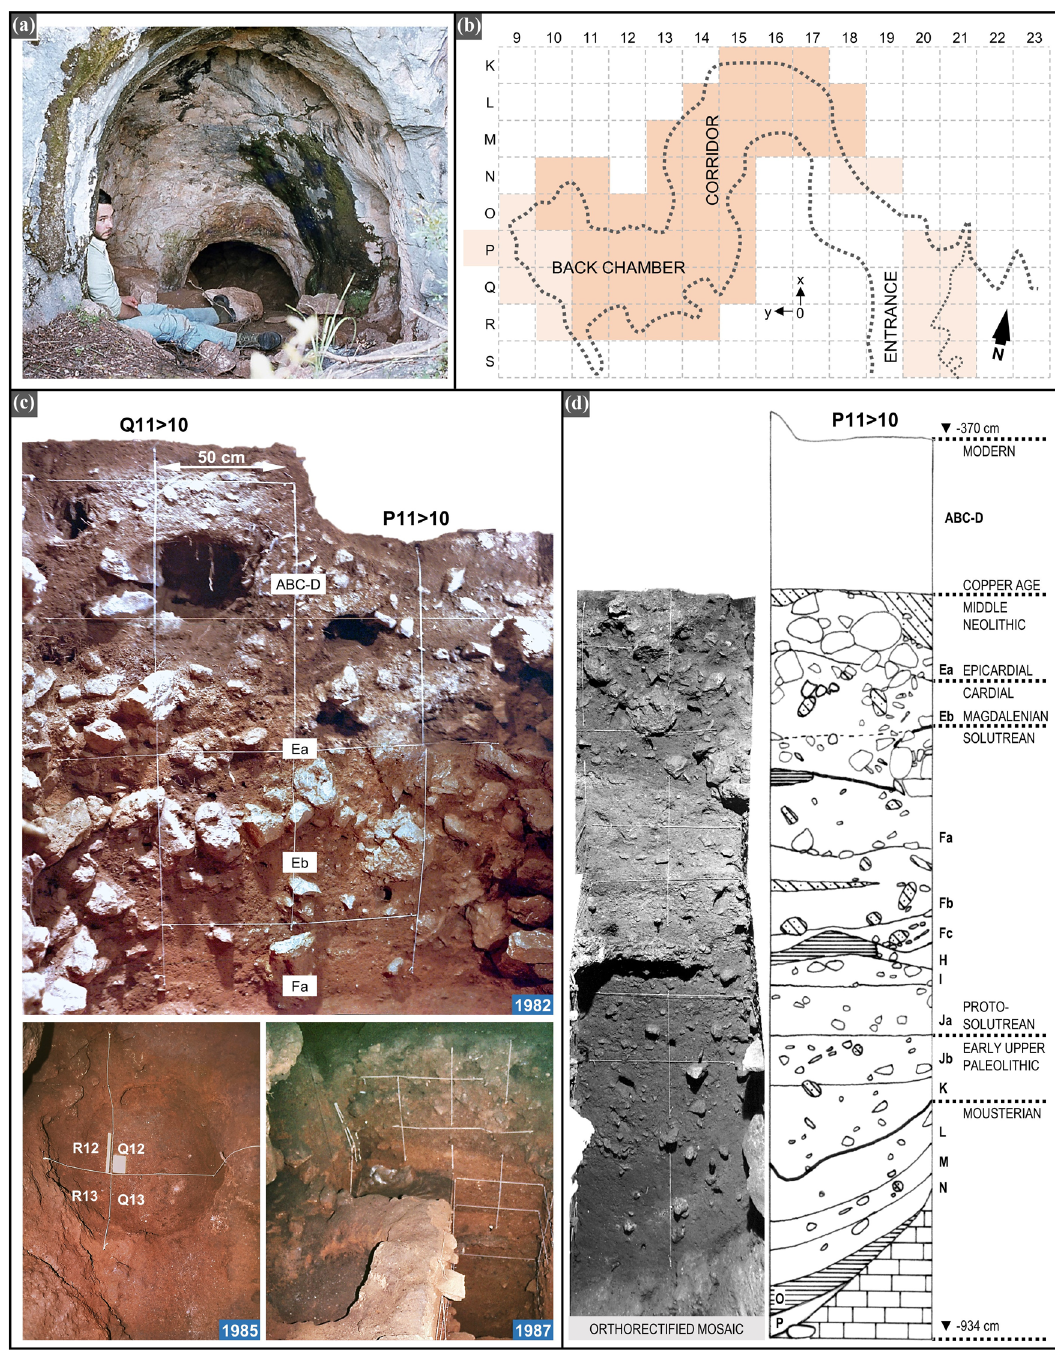
Figure 3: Gruta do Caldeirão. Excavation and stratigraphy. ( a ) The entrance to the cave in 1980, at the beginning of the second fi eld season. ( b ) Outline of cave walls at the surface of the sedimentary deposit and excavation grid ( in darker shade, those in which the Neolithic was excavated ) . ( c ) Stratigraphy and post - depositional disturbance in the upper part of the sedimentary fi ll ( top ) ; note the large subsurface hollows in layer ABC - D ( badger burrows ) and a comparable feature in squares Q - R/12 - 13, which was fi lled with a mix of Neolithic and Magdalenian material and penetrated deeply into the underlying Solutrean sequence ( bottom ) . ( d ) The reference pro fi le at the end of the 1988 fi eld season ( elevations in cm below datum )